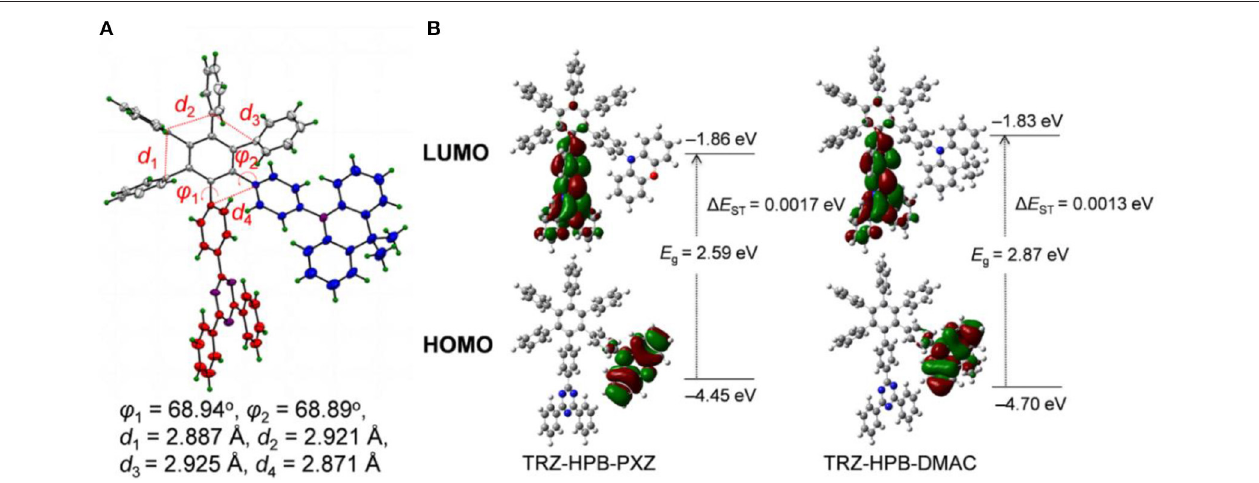
FIGURE 2 | (A) Crystal structure of TRZ-HPB-DMAC. (B) Spatial distributions of HOMO and LUMO, and 1 E ST values of the HPB-based molecules, calculated by DFT/TDDFT method.